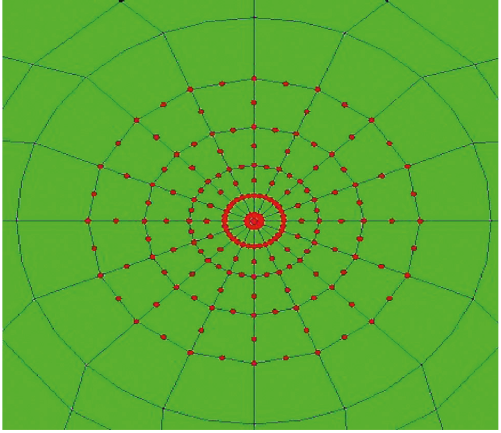
Figure 22: Meshing cantors around of crack tip.